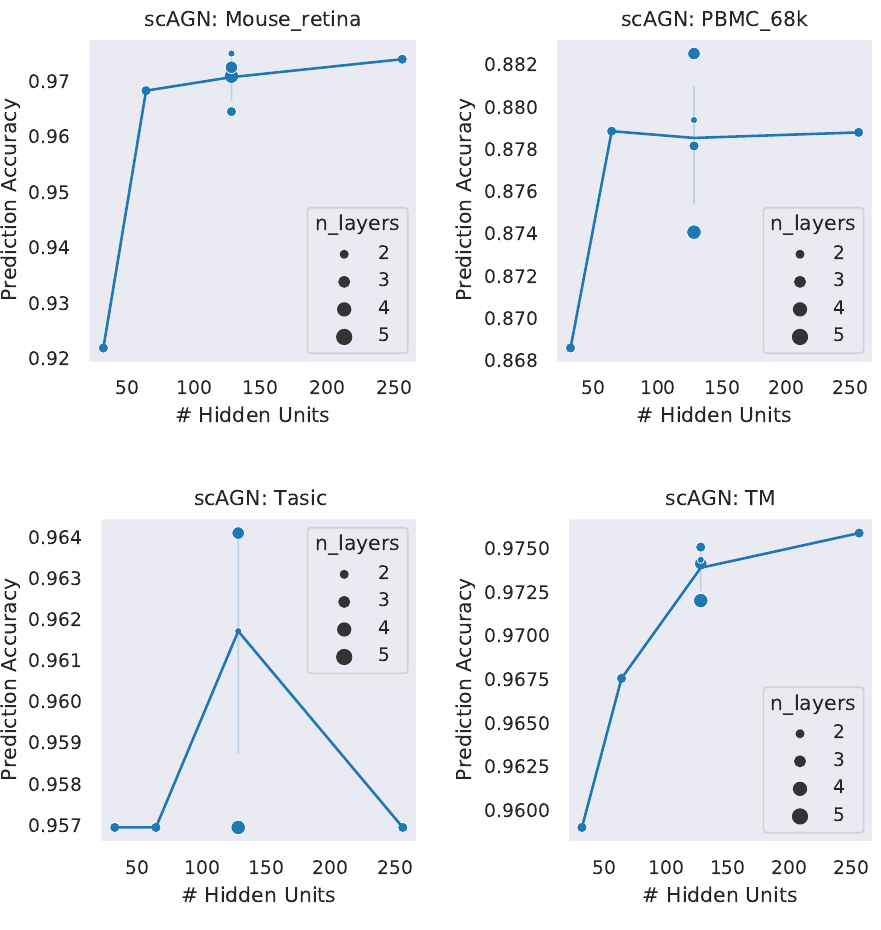
Figure 8. Prediction accuracy with the number of hidden units and the number of layers for healthy cells. The number of hidden units used were 32, 64, 128, and 256. The number of layers were varied from 2 to 5. The size of the bubble represents the number of layers used in the graph neural network. For a fixed hidden unit, the varying number of layers does not provide a definite conclusion on a trend of prediction accuracy with the number of layers. Lines were drawn passing through the average of the number of layers where the number of hidden units is fixed. With the Tasic dataset, we see an exception where the trend of prediction accuracy with the number of hidden units is